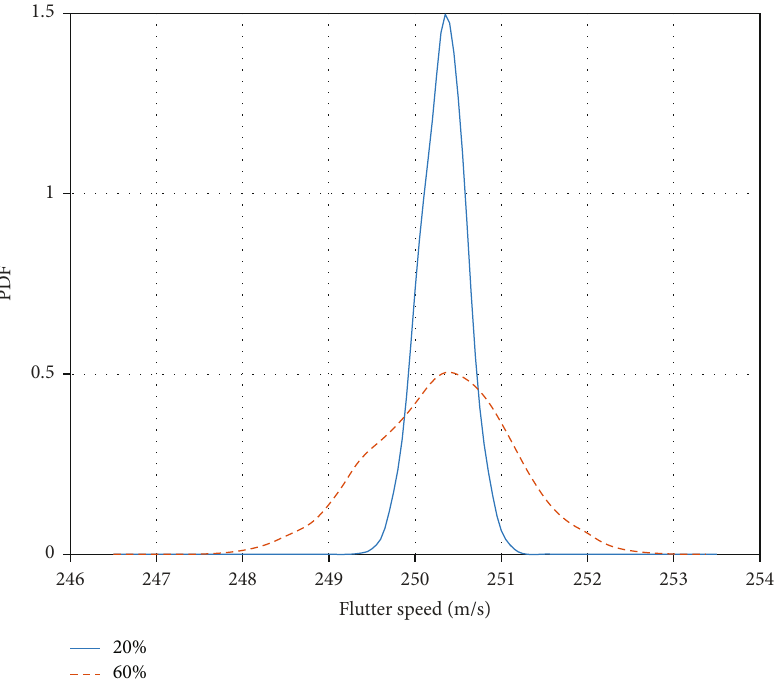
Figure 18: PDF of fl utter speed: deviation in the mode